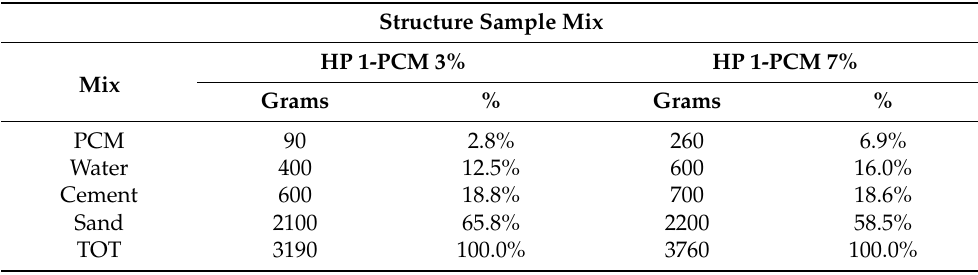
Table 1. Mixes adopted, highlighting the weight and percentage of the final compound.